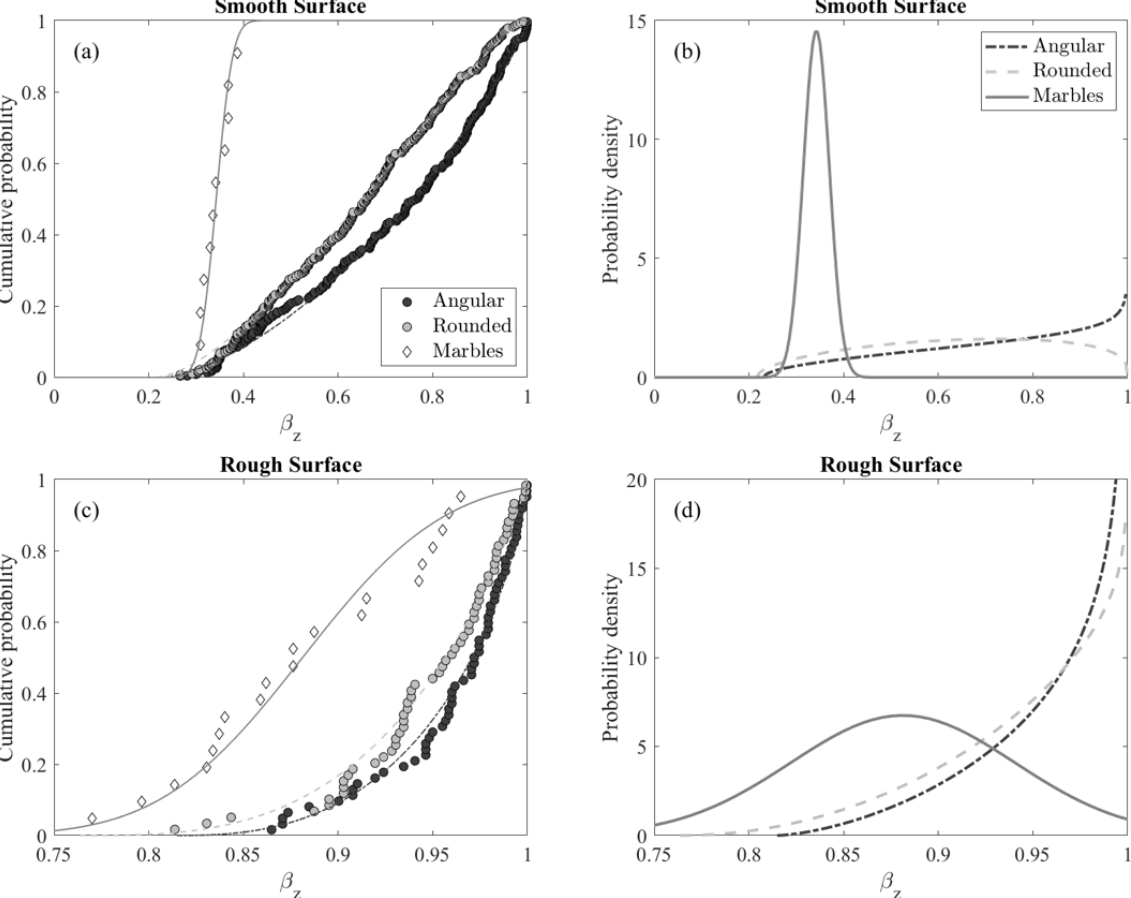
Figure 4. Drop experiment results of β z for glass spheres fit to a Gaussian distribution and rounded and angular gravel particles fit to a beta distribution shown with a (a) cumulative distribution plot for a smooth surface, (b) probability density plot for a smooth surface, (c) cumulative distribution plot for a rough surface, and (d) probability density plot for a rough surface.